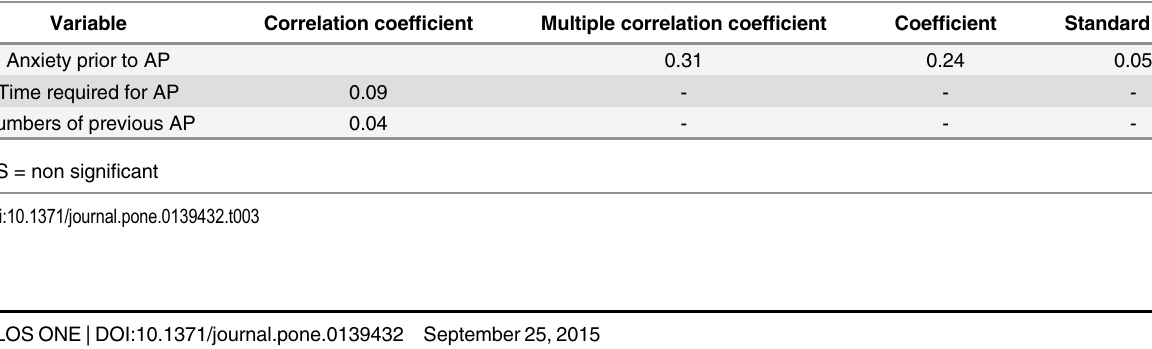
Fig 3. Correlations between anxiety and pain. (A) Correlation between anxiety prior to the arterial punctures and pain (rho:0.3694, p < 0.001), (B) Correlation between the pain experienced during the arterial punctures and the anxiety experienced with respect to future arterial punctures (rho:0.5124, p < 0.001), (C) Correlation between the anxiety experienced prior to the arterial punctures and the anxiety experienced with respect to future arterial punctures (rho:0.461, p < 0.001). doi:10.1371/journal.pone.0139432.g003 Table 3. Multivariate analysis: independent pain-related